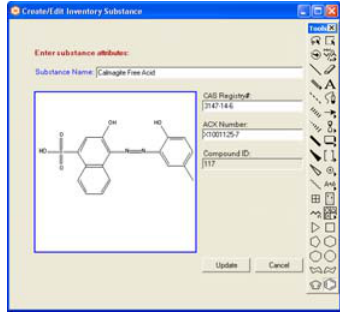
FIGURE 3: Create/Edit Substance form with ChemDraw